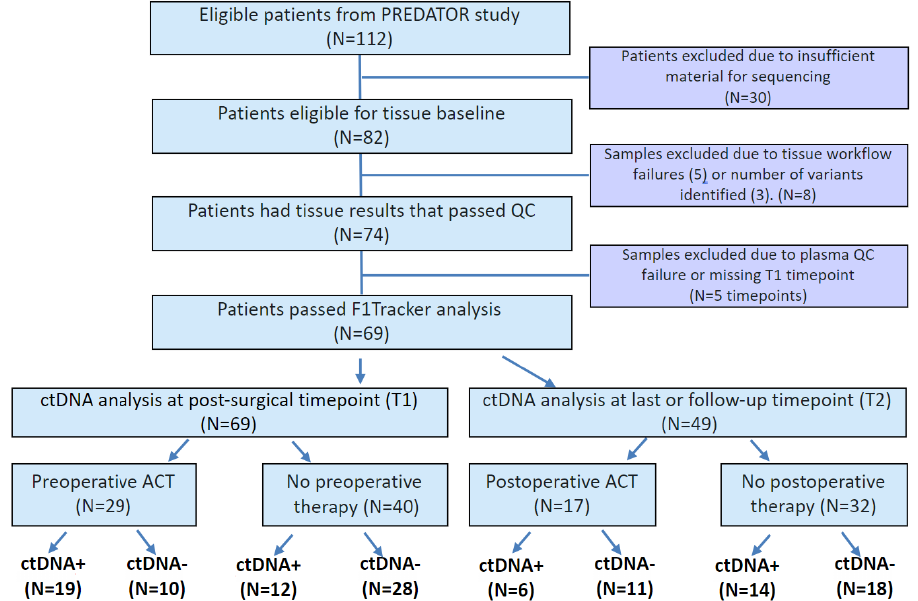
Figure 1. Consort Diagram of patients monitored with FoundationOne ® Tracker. PREDATOR study and full patient population are described previously [14]. ACT = adjuvant chemotherapy. Table 1. Patient demographics and baseline clinical characteristics. Abbreviations: FP = fluoropyrimi- dine; CEA = carcinoembryonic antigen; ctDNA = circulating tumor